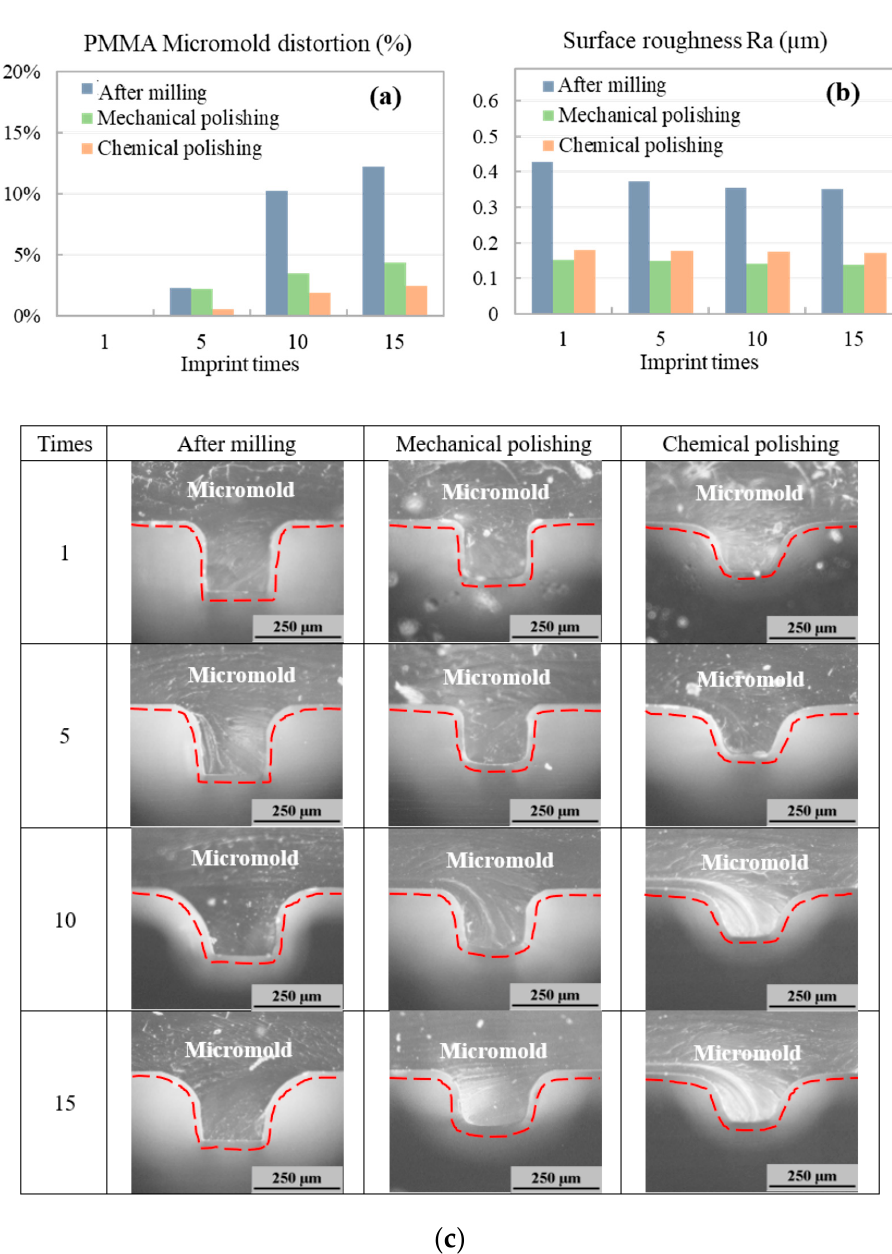
Figure 9. ( a ) PMMA micromold distortion percentage and ( b ) surface roughness after 15 imprint runs. ( c ) Cross-sectional images of micromold surfaces after 1, 5, 10, and 15 imprint runs.